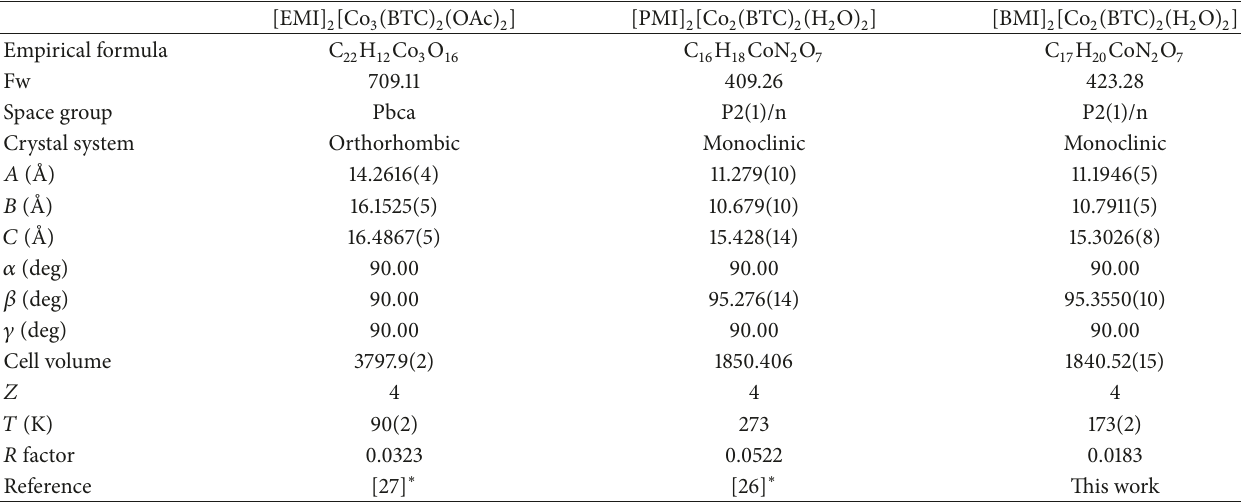
Table 1: Crystallographic data for Co-BTC metal organic frameworks synthesized with [RMI]Br ionic liquids (RMI = EMI, PMI, BMI).